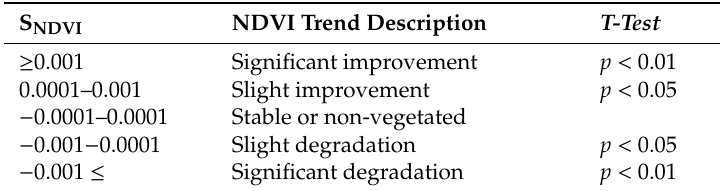
Table 1. Division of the degrees of variation of the normalized di ff erence vegetation index (NDVI) change trend. S NDVI NDVI Trend Description T-Test ≥